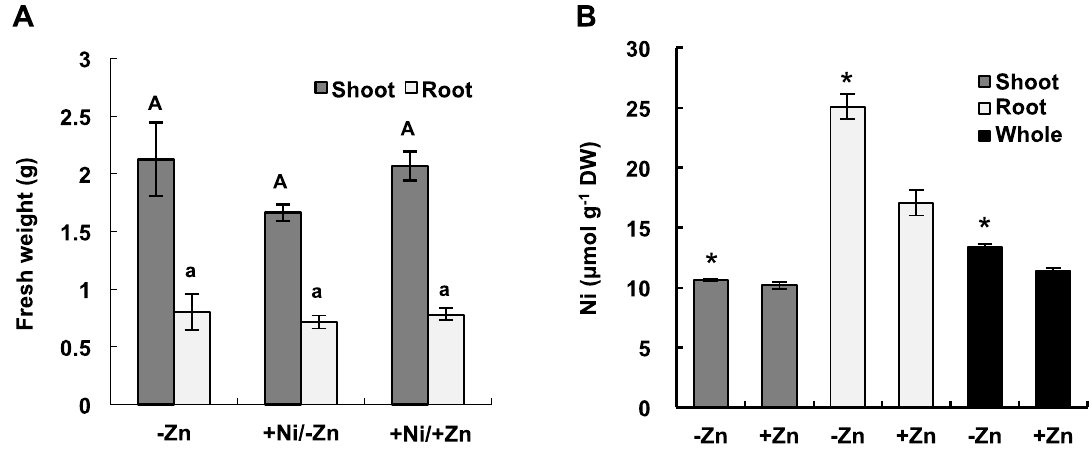
Figure 1. Ni accumulation in plants grown under Zn-sufficient or -deficient conditions. Four-week-old plants were exposed to 25 μmol·L −1 NiCl 2 under Zn-sufficient (5 μmol·L −1 ) or -deficient (0 μmol·L −1 ) conditions for 7 days in a hydroponic culture. ( A ) Fresh weight. The same letters in each series (uppercase for shoots and lowercase for roots) indicate no significant difference ( p ≥ 0.05, Steel-Dwass test) between treatments; ( B ) Ni concentrations in the shoots, roots, and whole plants. Asterisks denote significant differences ( p <